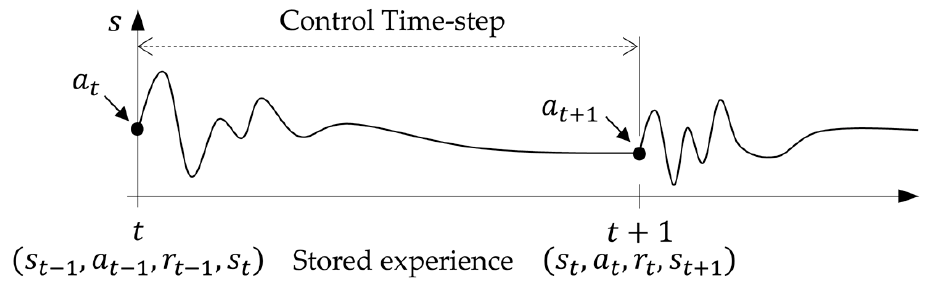
Figure 4. Agent time step versus system dynamics.